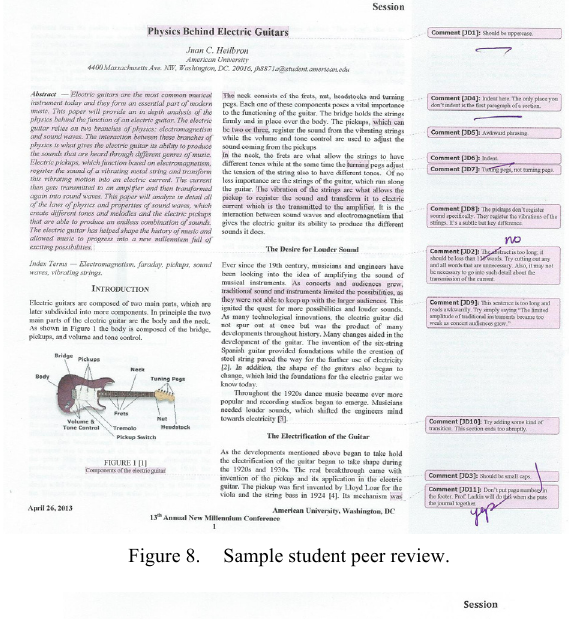
Figure 8. Sample student peer review.